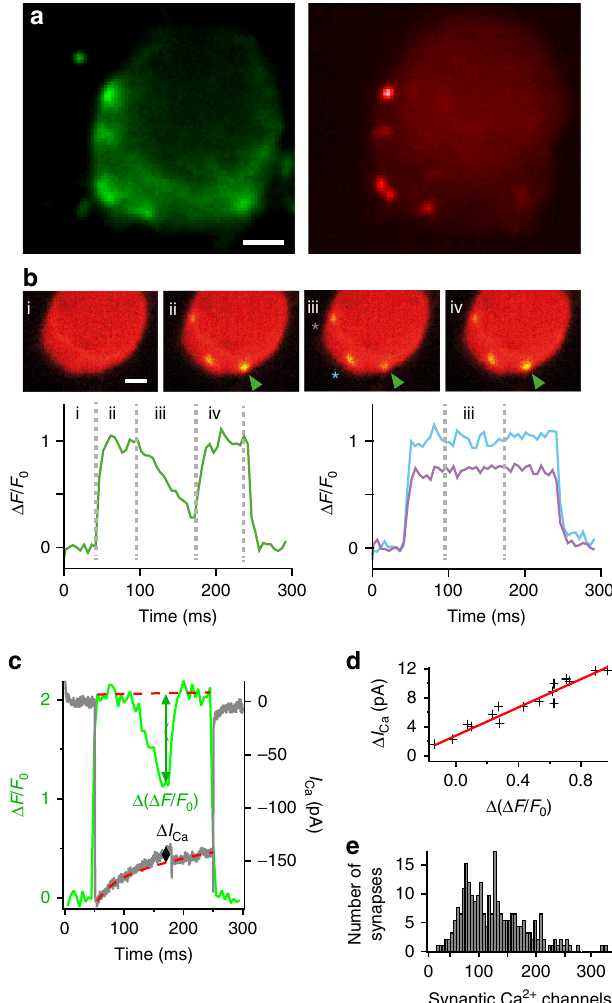
Fig. 3 Estimating the number of Ca 2+ channels per AZ by confocal Ca 2+ imaging with selective suppression of Ca 2+ in fl ux at individual AZs. a Representative image of hotspots of depolarization-evoked Ca 2+ in fl ux, visualized by increased fl uorescence of the Ca 2+ -indicator Fluo-8FF (green, left), localized at AZs that are identi fi ed by a TAMRA-conjugated peptide (red, right) binding to the synaptic ribbon. Scale bar: 1 µ m. b Hotspots of Ca 2+ in fl ux were additionally monitored in nearby AZs, also in different focal planes (500 and 1000 nm above and below the targeted AZ). Only those recordings were used where the targeted AZ (green arrowhead) showed a clear increase in fl uorescence (green trace, bottom left) from baseline (i) upon depolarization (ii), which decreased upon microiontophoresis of EGTA (iii) but returned to full intensity after the end of iontophoresis (iv) and where nearby AZs (blue and purple asterisks) showed no obvious change in fl uorescence (blue and purple traces, bottom right) due to iontophoresis. Scale bar: 1 µ m. c Representative recording showing modulation of the depolarization-evoked increase in fl uorescence at a single AZ (green, left axis) and of the evoked whole-cell Ca 2+ current (gray, right axis) by microiontophoresis of EGTA from a micropipette close to the AZ. Changes in fl uorescence increase ( Δ ( Δ F / F 0 )) and in whole-cell current ( Δ I Ca ) due to local depletion of extracellular Ca 2+ by EGTA are estimated as the difference between measured data and a double- exponential function fi tted to the data before and after iontophoresis (red dashed line). d Plotting Δ I Ca against Δ ( Δ F / F 0 ) allowed conversion of the synaptic fl uorescence increase of a single AZ into the corresponding 0.8 synaptic Ca 2+ current. Data are from the recording shown in c . e Histogram of estimated numbers of Ca 2+ channels per synapse from recordings of depolarization-evoked Fluo-8FF- fl uorescence intensity increase due to Ca 2+ in fl ux. With the average slope of 14.3 pA, the hotspot intensities from a larger data set of n = 234 AZs ( N = 25 IHCs) could be converted into currents. From these, an expected number of Ca 2+ channels could be calculated using the assumptions of a single-channel current of i Ca = 0.29 pA and an open probability of p o = 0.4. On an average, a synapse